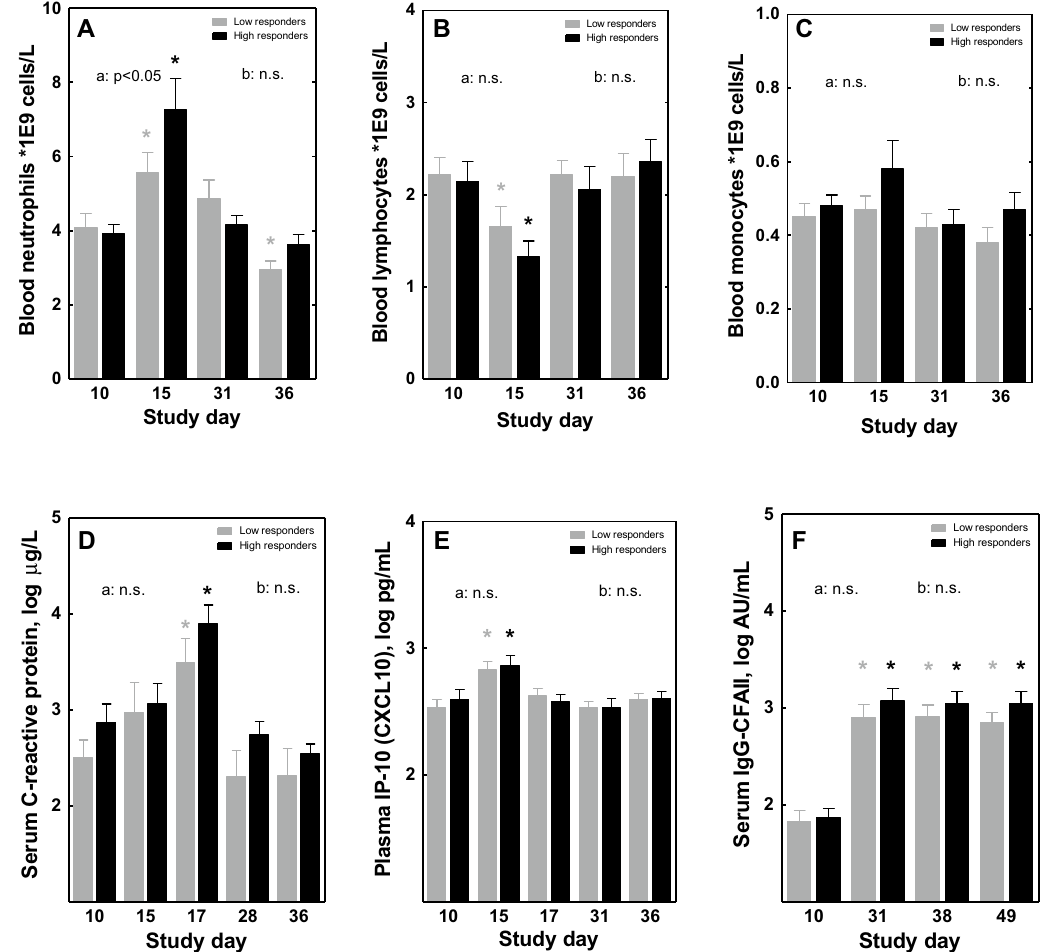
Figure 4. Effect of oral E. coli E1392/75-2A challenge on systemic inflammatory and immune biomarkers. In blood of high- and low-responders (n = 12 each), lymphocyte, neutrophil and monocyte counts were measured ( A – C ). In serum or plasma, levels of C-reactive protein, IP-10 (CXCL10) and CFA/II-specific IgG were measured ( D – F ). On day 14, subjects were orally infected with E. coli strain E1392/75-2A (dose 1E10 CFU or 5E10 CFU). On study day 35, all subjects received a second inoculation of 1E10 CFU of E. coli . Results are shown as means ± SEM. Timepoint at which significance is reached as compared to baseline day 10 (within the first infection period) or day 28/31 (within the second infection period) is indicated by *, with p < 0.05 within the specified group (repeated measures ANOVA; black *within high-responders; grey *within low-responders). Significant differences in the overall response between high- and low-responders (two-way ANOVA) are indicated separately for the first ( a , days 10–31) and second ( b , days 28/31–49) infection period; ns not